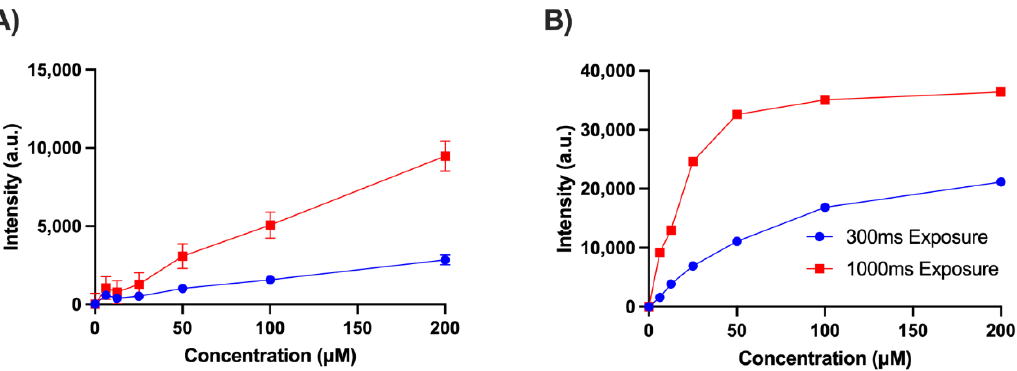
Figure 3. ( A ) NADH and ( B ) FAD standard curves with a concentration range between 0 – 200 µM with 3.3% Intralipid at 300 ms (blue) and 1000 ms (red) exposure times. The signal was background subtracted using the 0 µM readings.